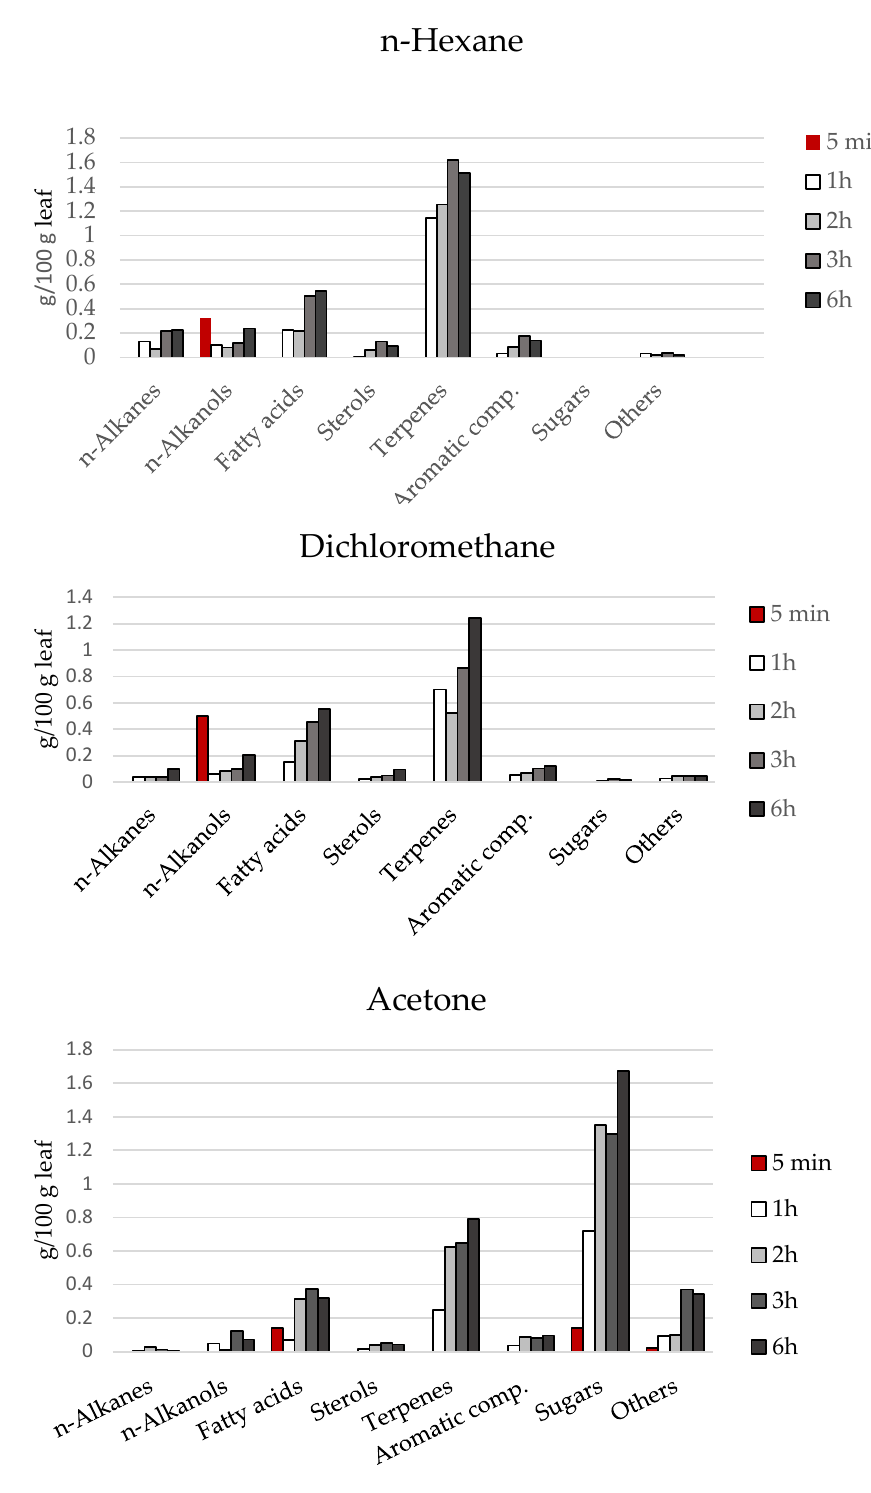
Figure 2. Composition (g/100 g leaves) by chemical family of the cuticular lipids extracted from Q. suber leaves with different solvents and extraction time.